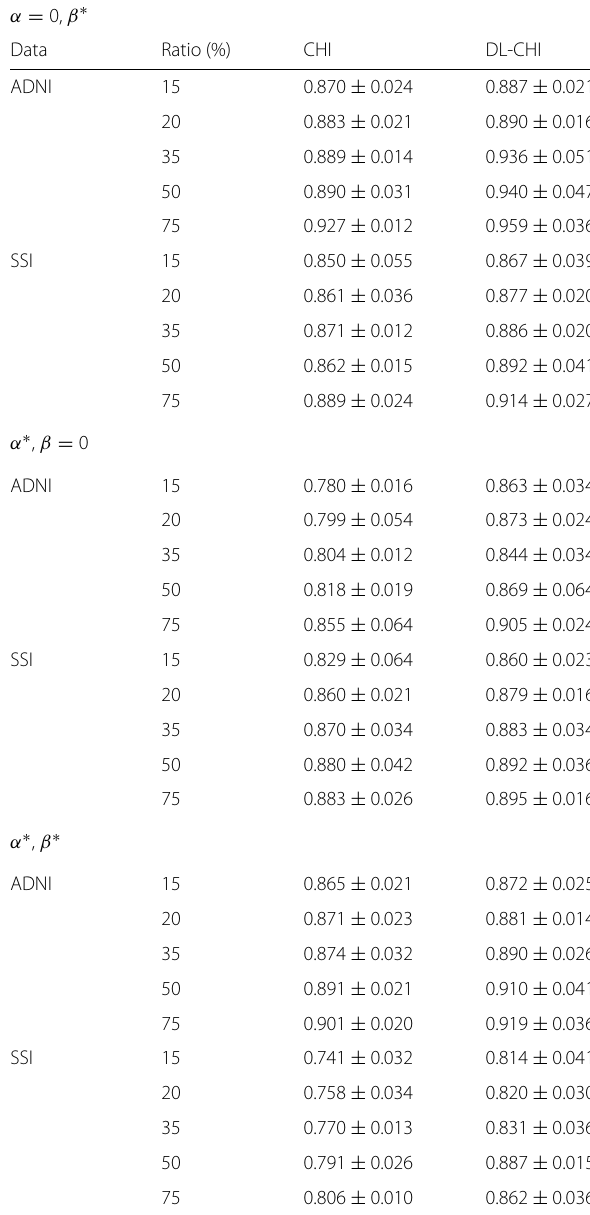
Table 1 AUC performance for ADNI and SSI data across different ratio of training and testing datasets obtained by 10-fold